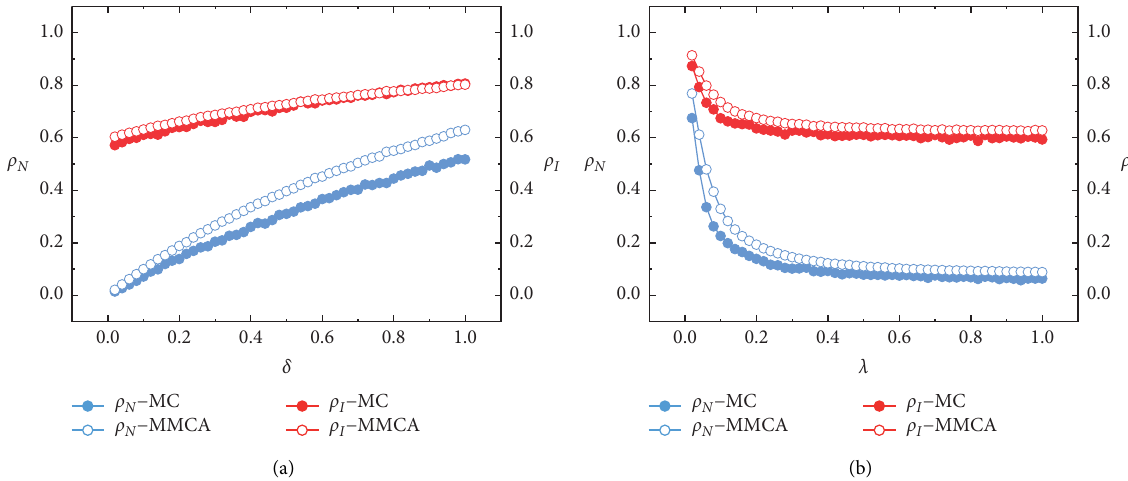
ρ −MC ρ −MC Ν Ι ρ −MMCA ρ Ν Ι Figure 4: The final fractions ρ I and ρ N of the infected nodes and the noresource nodes as a function of the resource loss rate δ (a) and the resource diffusion rate λ (b). The symbols are the same as in Figure 3. The results show that both ρ I and ρ N increase with δ but decrease with λ . And, a smaller λ ( ∼ 0 . 2 ) can dramatically reduce ρ I , indicating the diffusion of individual resources is of importance for suppressing the spread of disease. The other fixed parameters are β � 0 . 70, μ � 0 .